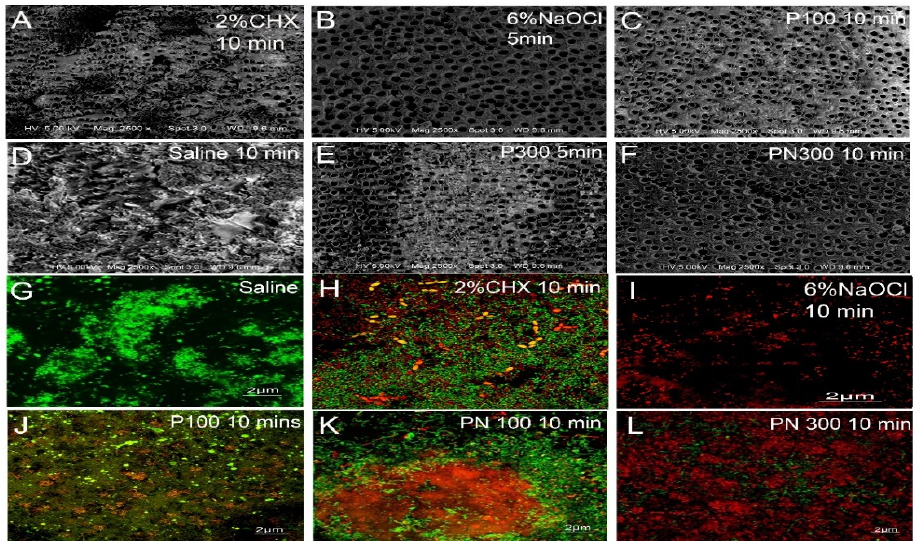
10 of 17 Figure 2 . ( A ) Mean reduction in CFU at 1, 5, and 10 min at 200 µm dentinal tubule depth. ( B ) Mean reduction in CFU at 1, 5, and 10 min at 400 µm dentinal tubule depth. ( C ) Comparison of CFUs count between propolis nanoparticles (PNs) and other endodontic irrigants at 1, 5, and 10 min against Enterococcus faecalis isolates from patients with failed root canal treatment. Groups identified by different alphabets and symbols were significantly different at p < 0.05 in columns, respectively. The alphabets and symbols are in quasi-alphabetical order and are ordered according to the statistical difference between groups. SEM images verified the presence of a thick biofilm of bacteria when treated with saline. At five and ten minutes, the saline group showed the highest E. faecalis coverage of 67–100% on SEM images of the canal wall. At five minutes, 6% NaOCl and 2% CHX showed the least E. faecalis coverage of 5–33%, while PN300 showed 34–66%. At ten